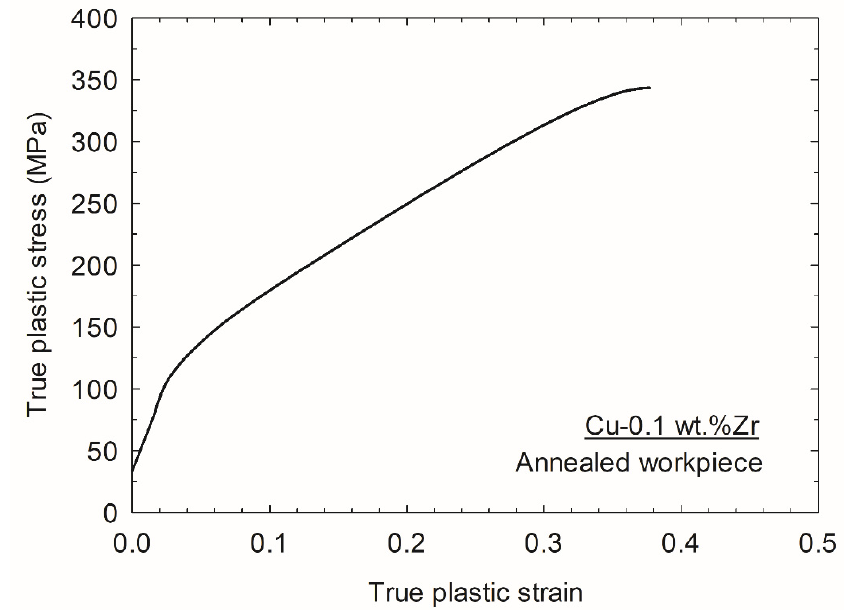
Figure 2. Experimental true plastic stress–strain curve for the Cu-0.1% Zr alloy. Table 1. Material properties of an annealed specimen of Cu-0.1 wt.% Zr. Properties.